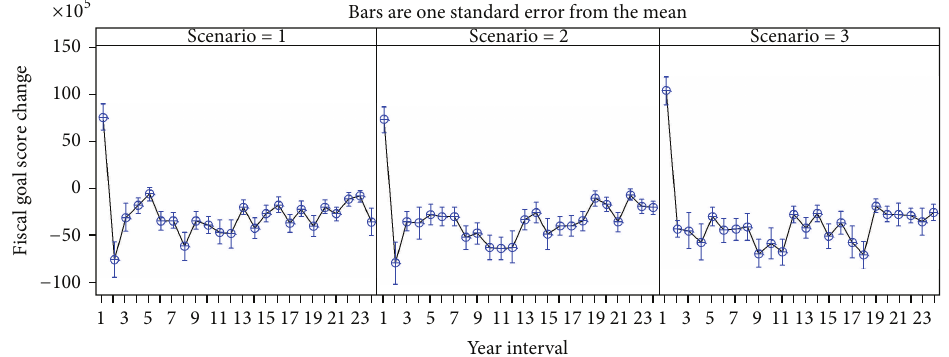
Figure 5: Fiscal goal score change interval plots by scenario and year. This graph illustrates the one standard error intervals for the mean of the 10 runs within each of the 3 scenarios: no. 1—baseline, no. 2—socioeconomic, and no. 3—biophysical change. Comparison across year by scenario for goal scores shows the relationship between harvesting actions and their improvement on fiscal goal